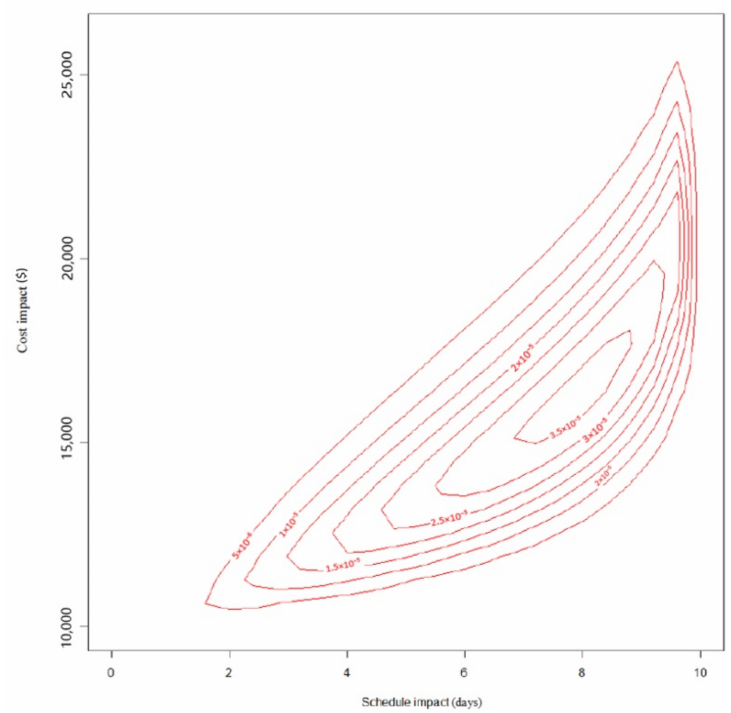
Figure 15. Contour plot of the joint probability density function.